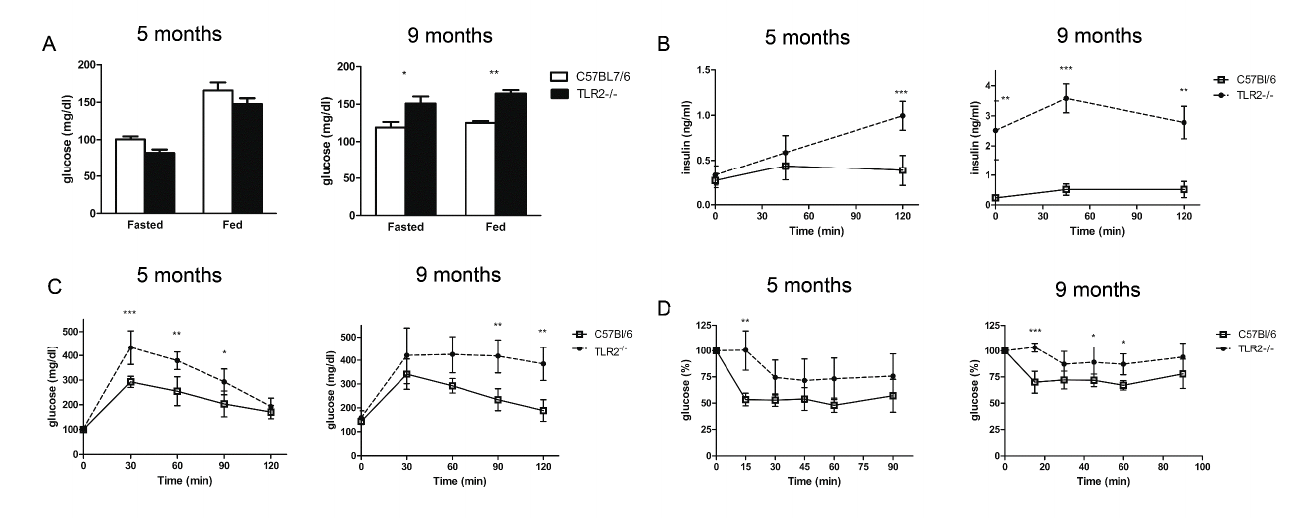
Figure 4. TLR2 − / − mice develop insulin resistance. ( A ) Serum concentrations of glucose in TLR2 − / − vs. WT mice at 5 and 9 months of age during the fed and fasted states. ( B ) GTT of TLR2 − / − vs. WT mice at 5 and 9 months of age. ( C ) Serum insulin levels during the glucose tolerance test (n = 5 per group, two-way ANOVA). ( D ) ITT of TLR2 − / − vs. WT mice at 5 and 9 months of age (n = 5 per group, two-way ANOVA, * p < 0.05, ** p < 0.01, *** p < 0.001). Values are represented as mean ±